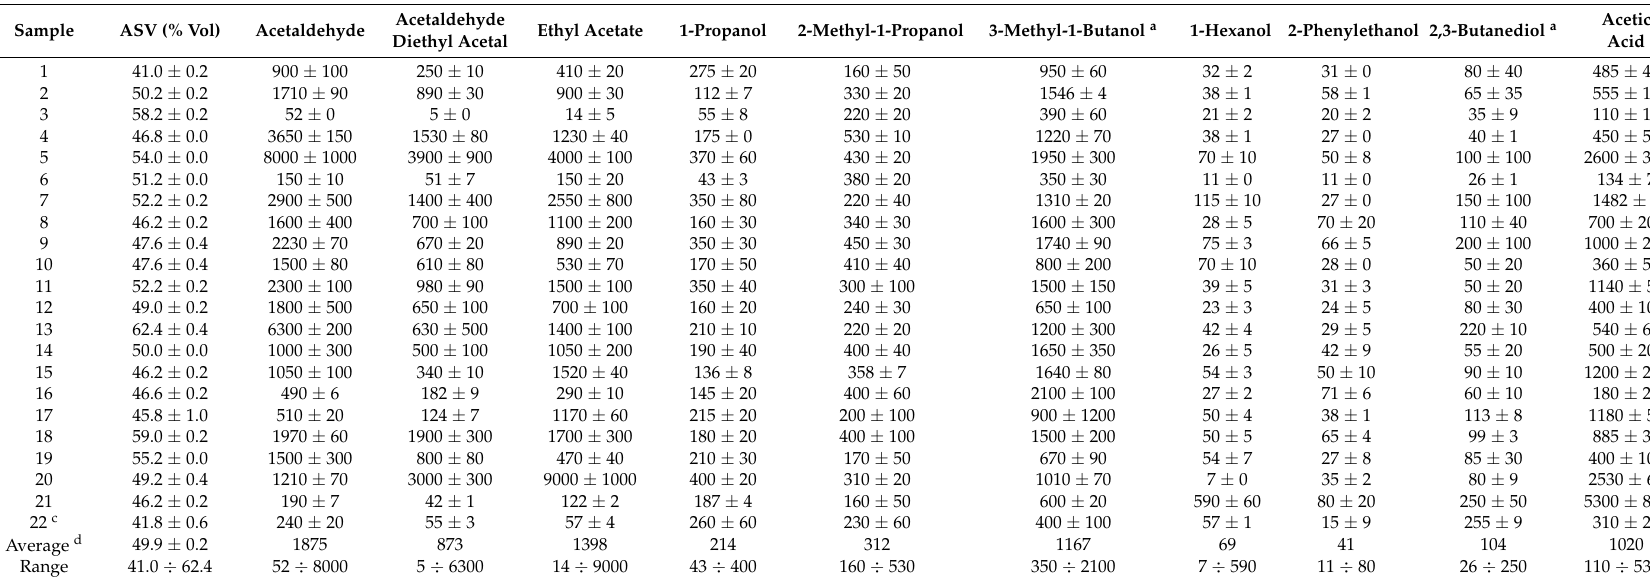
Table 4. Alcoholic strength by volume (ASV) (%( v / v ) ± SD; n = 2) and GC-MS quantification (mg dm − 3 ± SD; n = 3) of the principal volatile compounds in Filuferru